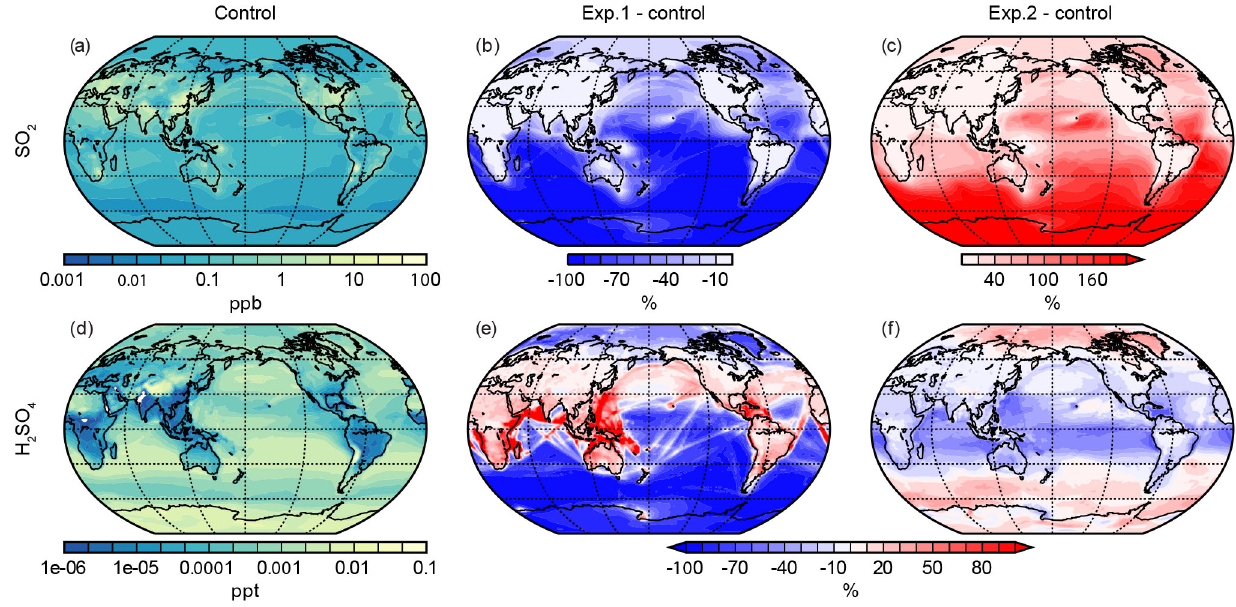
Figure 6. Mean (2000–2009) values for the Ctl (a, d) , the difference between Exp.1 (zero DMS w ) and the Ctl (b, e) and the difference between Exp.2 (zonally enhanced DMS w ) and the Ctl (c, f) . Panels (a) , (b) and (c) show the volume mixing ratio of SO 2 in ppb; (d) , (e) and (f) show the volume mixing ratio of H 2 SO 4 in